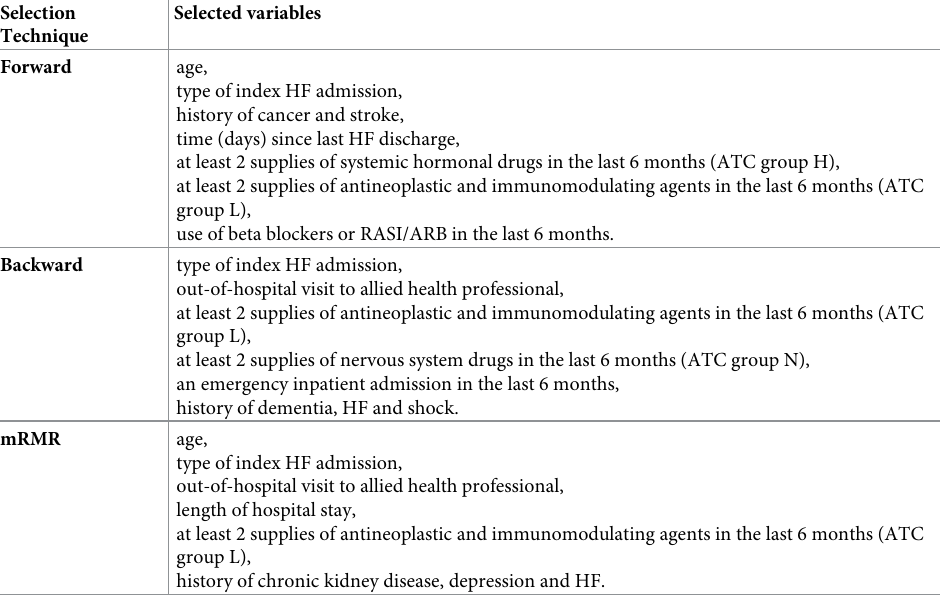
Table 3. Variables selected by the wrapper-based machine learning techniques for predicting 30-day HF readmis- sion or death. Selection Technique